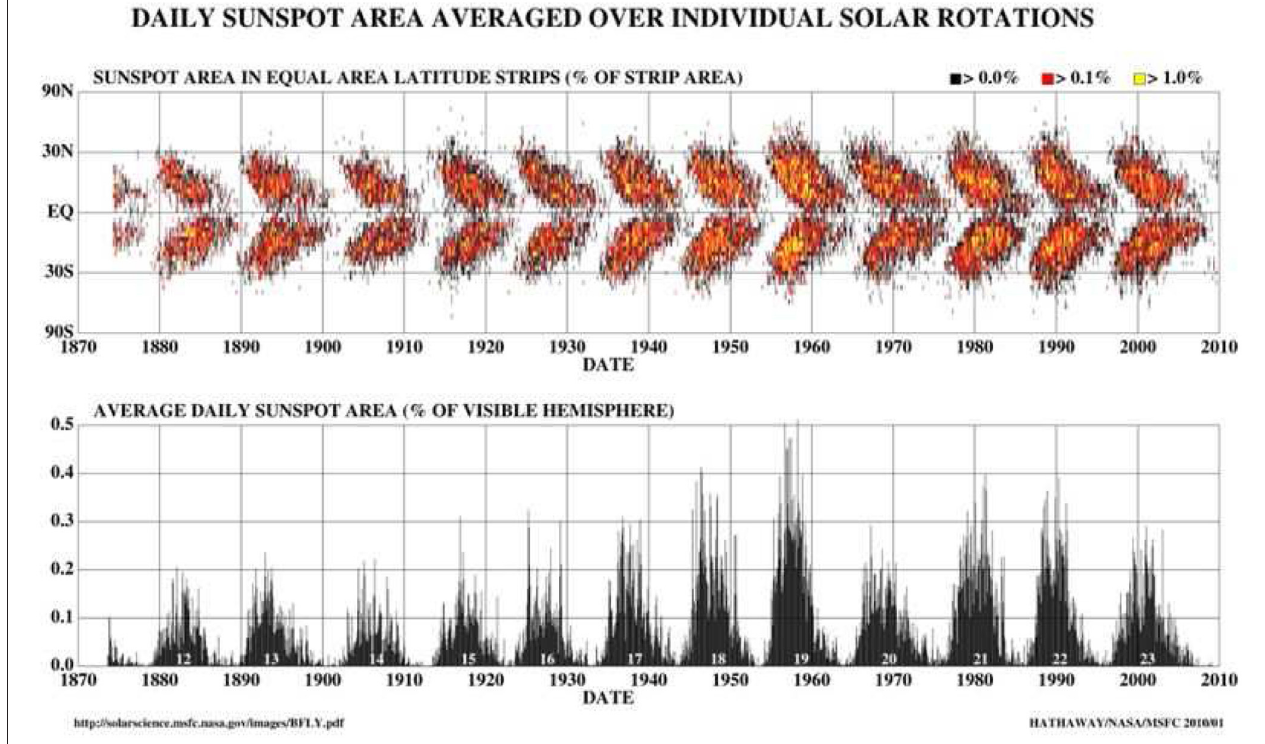
FIGURE 1 | The observed variation in sunspot number (Bottom) and latitude (Top) demonstrate the typical 11-year solar cycle. In the (Top) , the sunspot locations and their latitudinal variations are shown, which constitutes the butterfly diagram.Note that the sunspot butterfly wings grow abruptly at latitudes largely inside ∼ 35 ◦ . In the (Bottom) , the total sunspot number and its variations are shown over various solar cycles [Credit: Hathaway, 2010, reproduced with permission (c) Springer